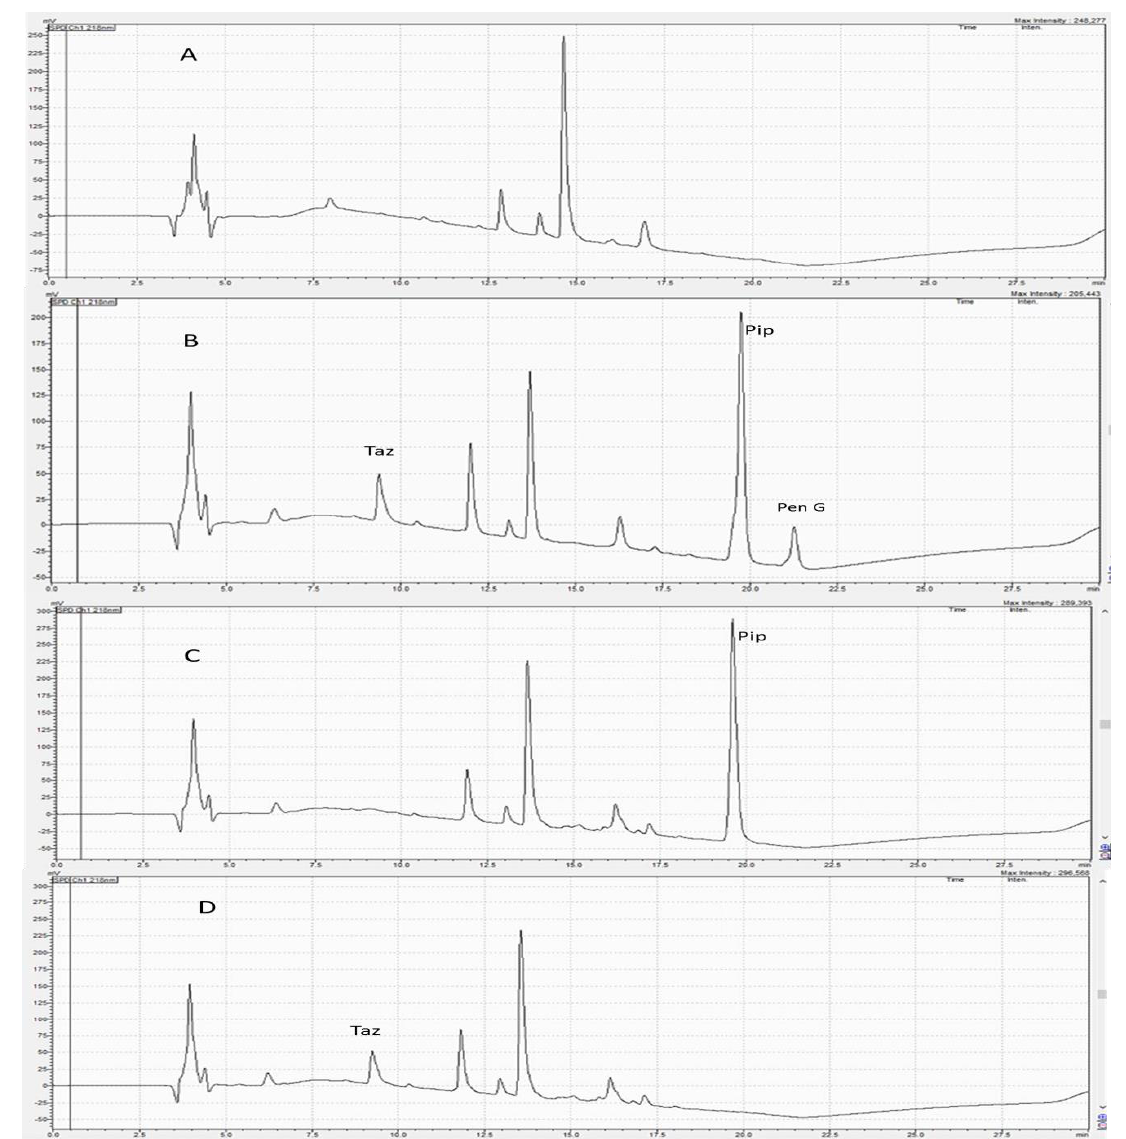
Figure 2. ( A ) A chromatogram of blank plasma; ( B ) a chromatogram of plasma containing piperacillin, tazobactam and penicillin G (IS); ( C ) a chromatogram of plasma sample containing piperacillin only; ( D ) a chromatogram of plasma containing tazobactam only. Retention times determined for tazobactam, piperacillin, and penicillin G (IS) were 9.2, 19.6 and 21.4 min,